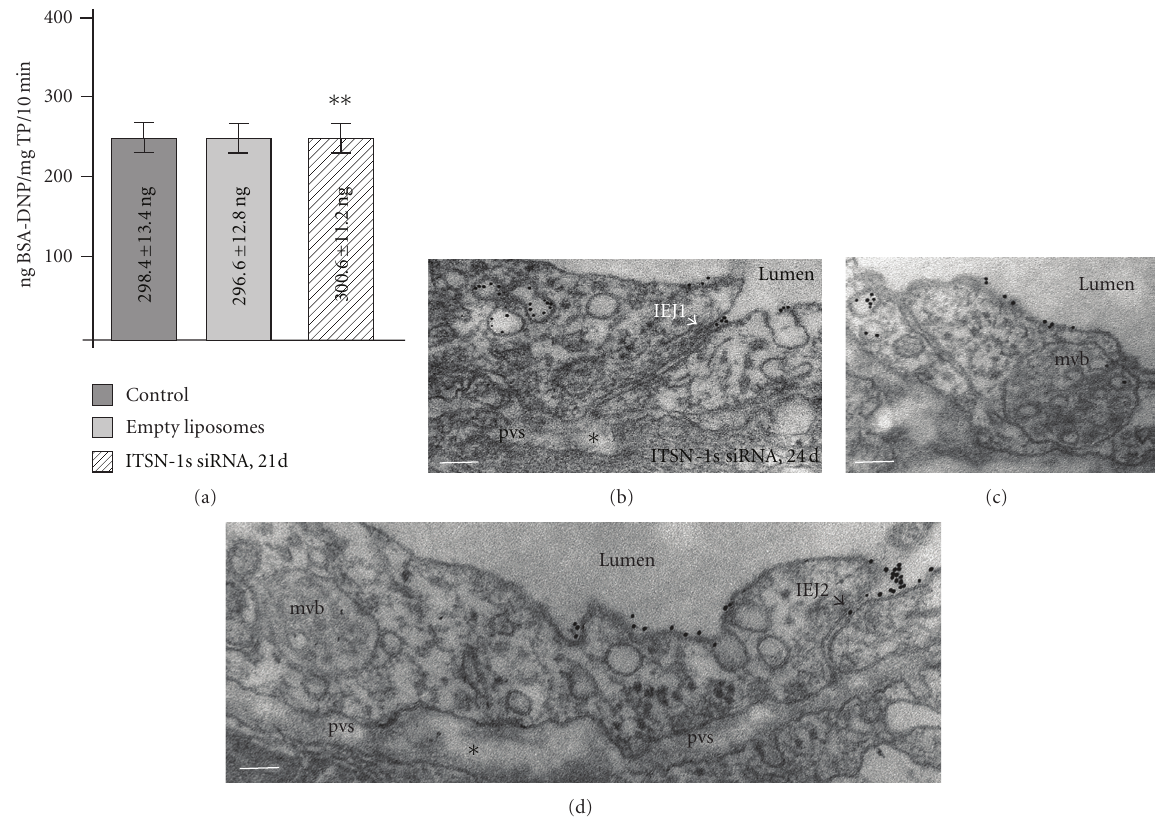
Figure 5: Chronic inhibition of ITSN-1s expression partially restores caveolae number and IEJ integrity. (a) ELISA applied on mouse lung lysates of control, empty liposomes, and ITSN-1s siRNA-treated mice, 24 d alter delivery, perfused with 10 mg/mL BSA-DNP, for 10 min. Results were obtained in 4-5 di ff erent experiments, (3 mice/experimental condition), and expressed in ng BSA-DNP/mg total protein/10 min. Bars ± SD. (b, d) Filtration residues in the luminal introit of two IEJs (arrowheads). Mild dilation ( ∗ ) of the pvs suggests leakiness of the IEJs. Multivesicular bodies (mvb), in close proximity of the plasma membrane, have some of their internal small vesicles, labeled by 8 nm Au-BSA particles (c, d). Bars: 100